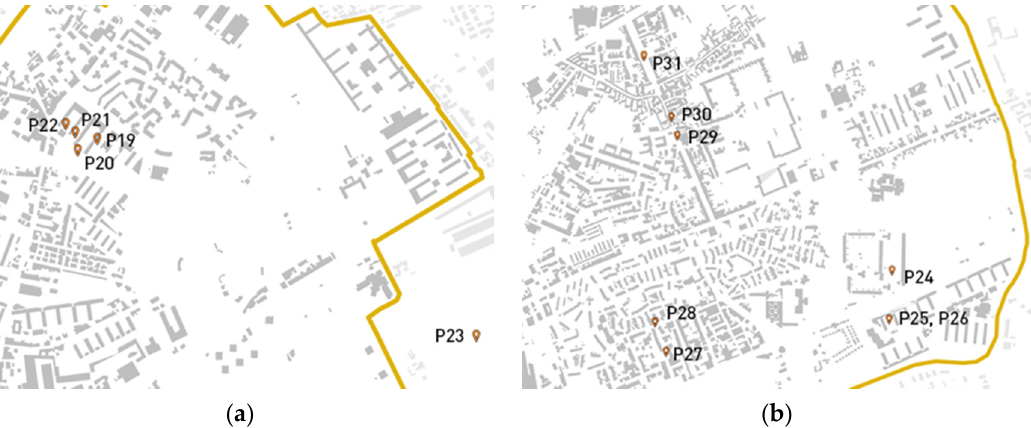
Figure A2. Location of the detected points during the survey of the environmental conditions of the Ponticelli district: ( a ) 3 July 2015, h. 11:00–12:00; ( b ) 3 July 2015, h. 12:30–15:00.